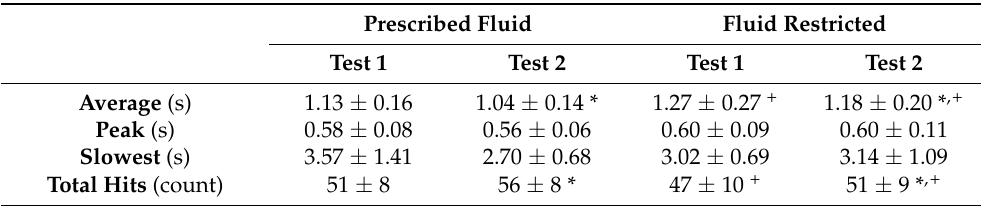
Table 2. Peripheral visuomotor reaction time tests. Data are presented as mean (m) ± standard deviation